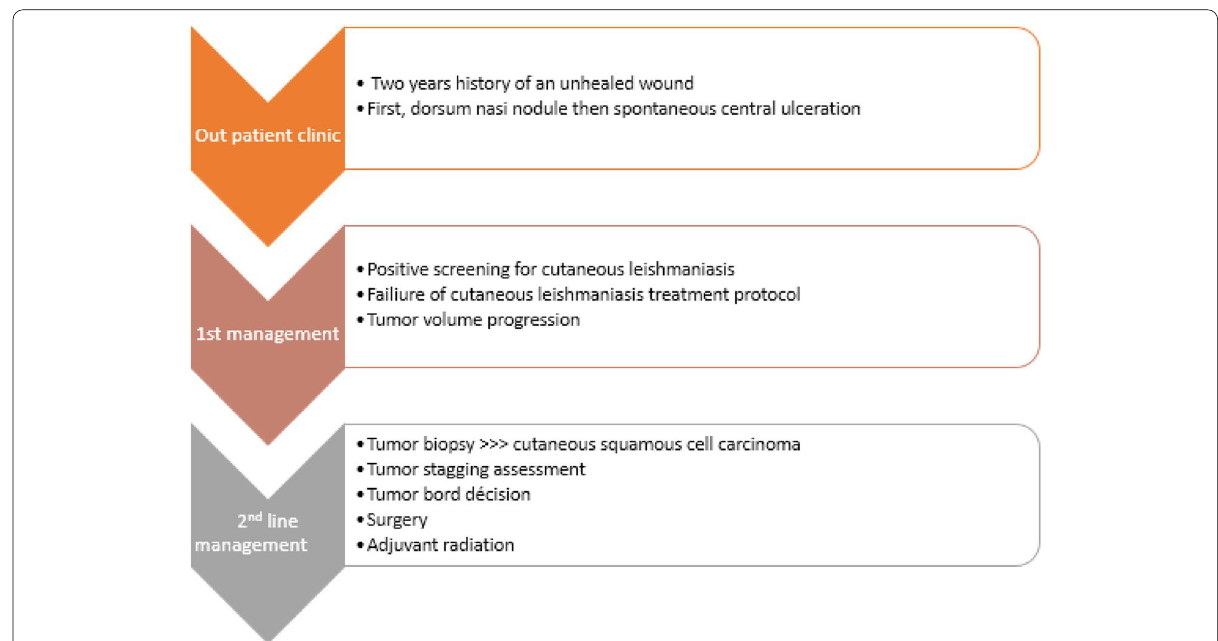
Fig. 4 Timeline of the patient’s episodes of